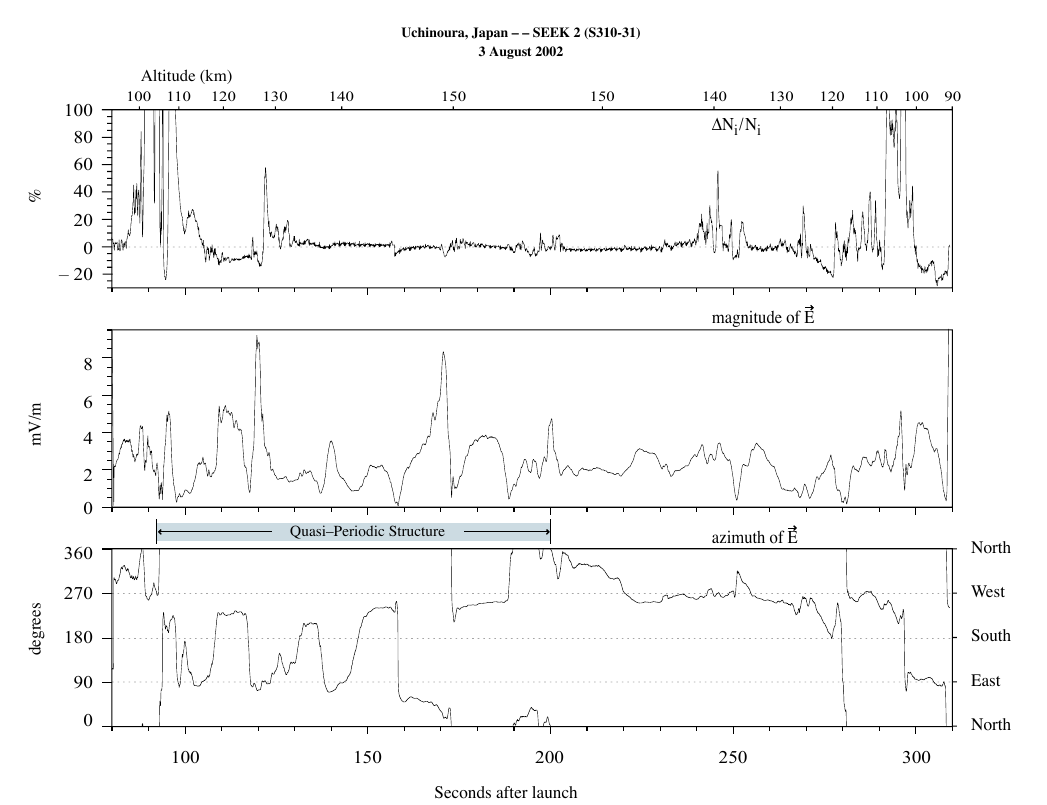
Fig. 9. The electric field structures (middle and lower panels) compared to the plasma density variations 1 N/N (upper